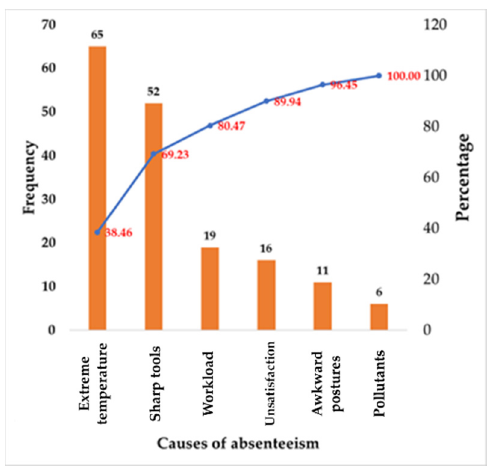
Figure 4. Example of a Pareto chart application for causes of absenteeism.